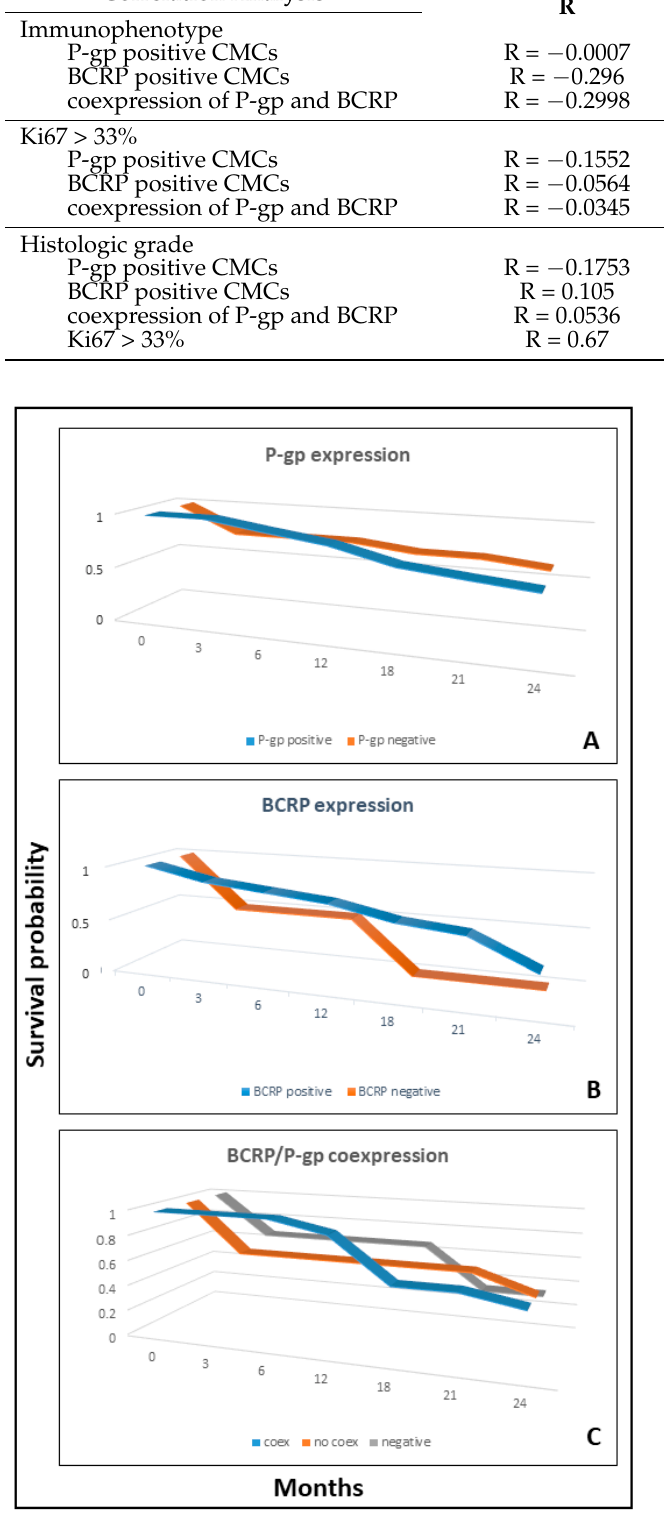
Figure 4. Survival curves of P-gp positive versus negative tumors (Panel ( A )), the same comparison for BCRP (Panel ( B )) and the comparison among groups expressing both markers (coex) vs. those expressing only one (no coex) or negative to both (Panel ( C )). Survival analysis p > 0.05 in all